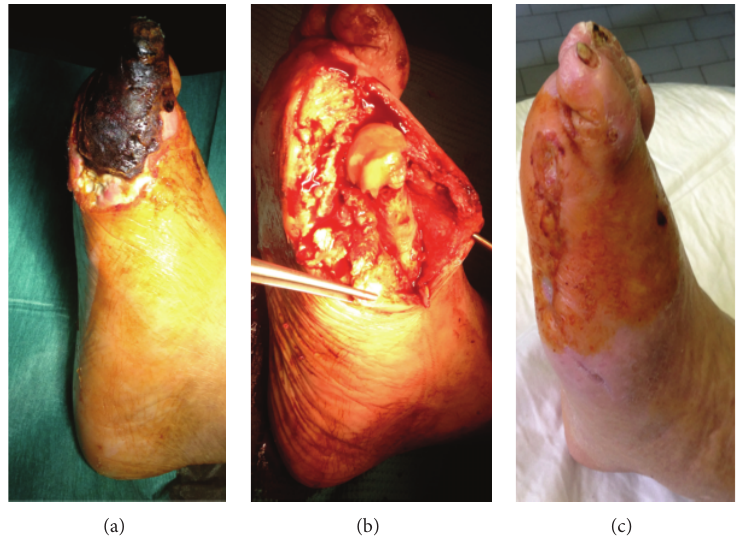
Figure 3: Preoperative (a), intraoperative (b), and follow-up images (c) of DF ulcers.